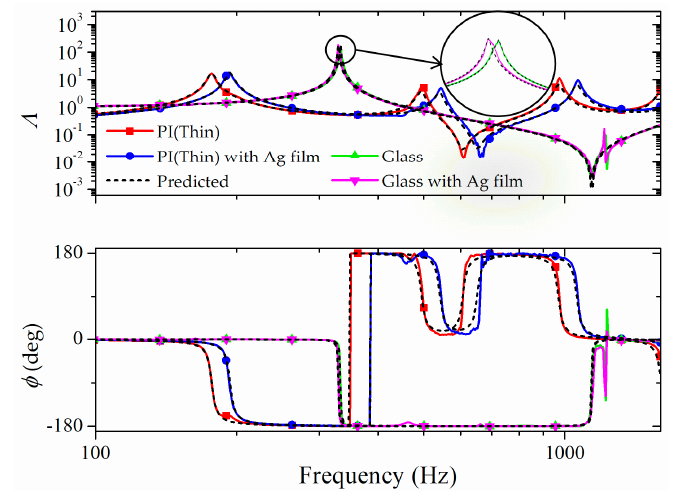
Figure 4. Measured transfer function of Ag-printed beams on PI and glass substrates. The alterations of vibration responses due to the printing process showed different tendencies according to substrate.